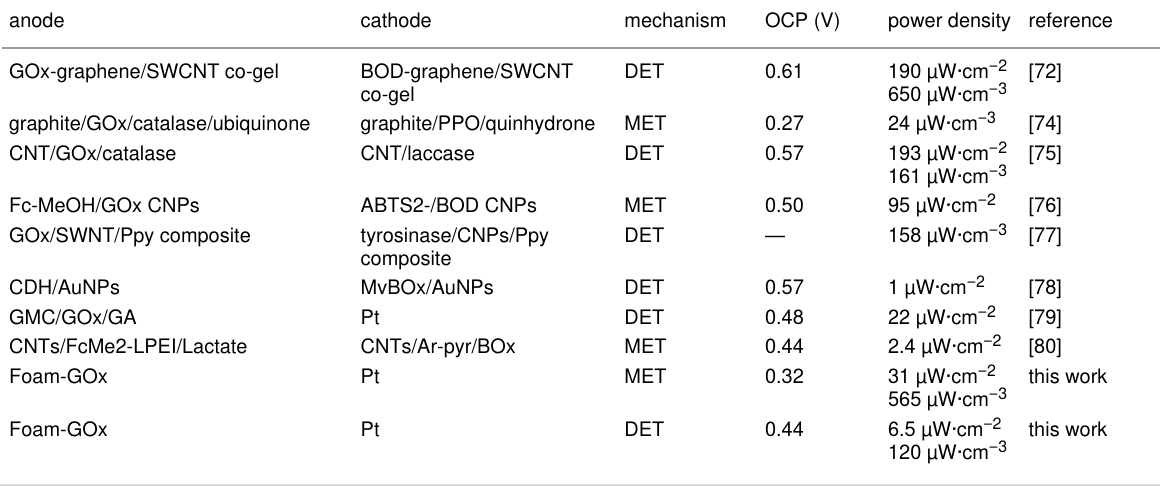
Table 3: Performance of different published EBFC systems utilizing DET or MET mechanisms. anode